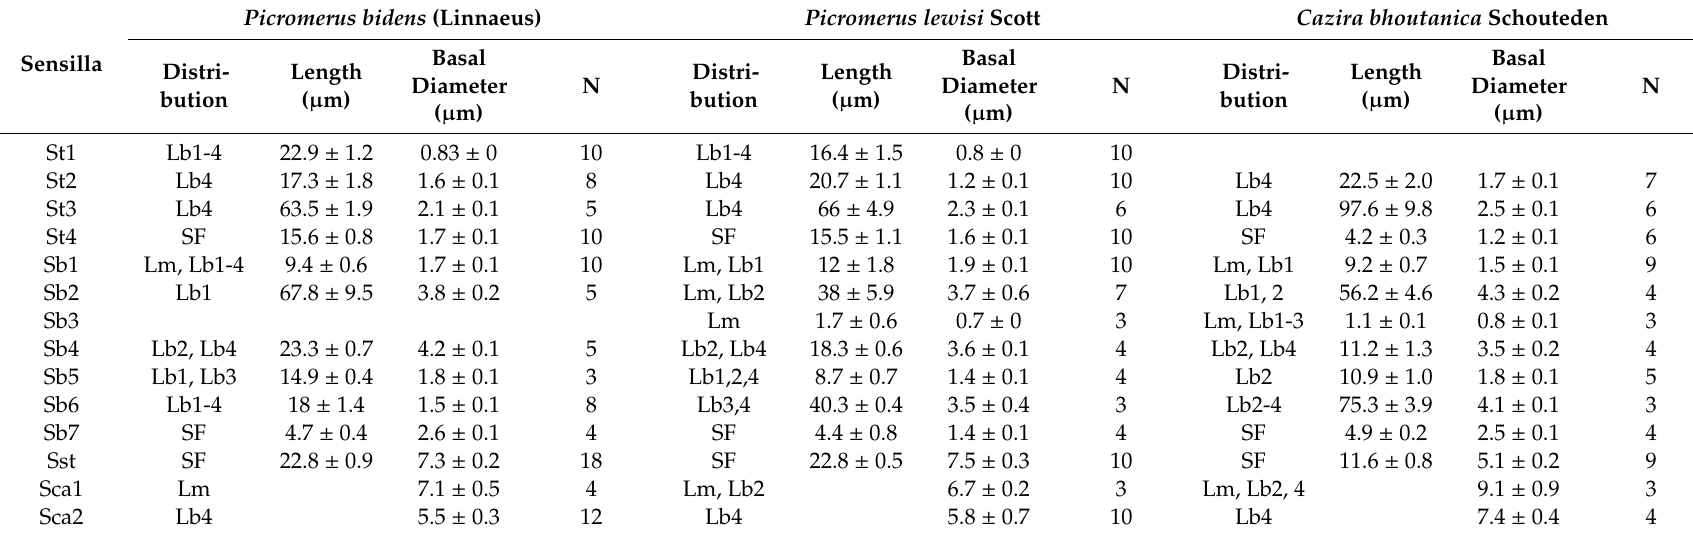
Table 2. Distribution and morphometric data of sensilla in studied species. Data are means ± SE values obtained from scanning electron microscopy. N = sensilla number; Lm, Labrum; St1–4, sensilla trichodea I–IV; Sb1–7, sensilla basiconica I–VII; Sst, Sensilla styloconica; Sca1–2, sensilla campaniformia I–II; Lb, labium; Lb1, 2, 3, 4, the first, second, third, fourth segment of labium; SF, sensory field on the labial